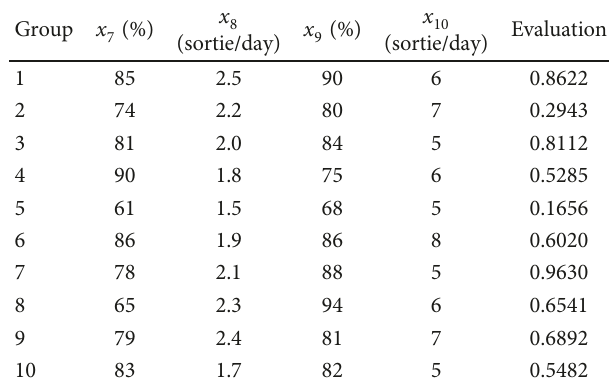
Table 4: Aircraft availability capacity.